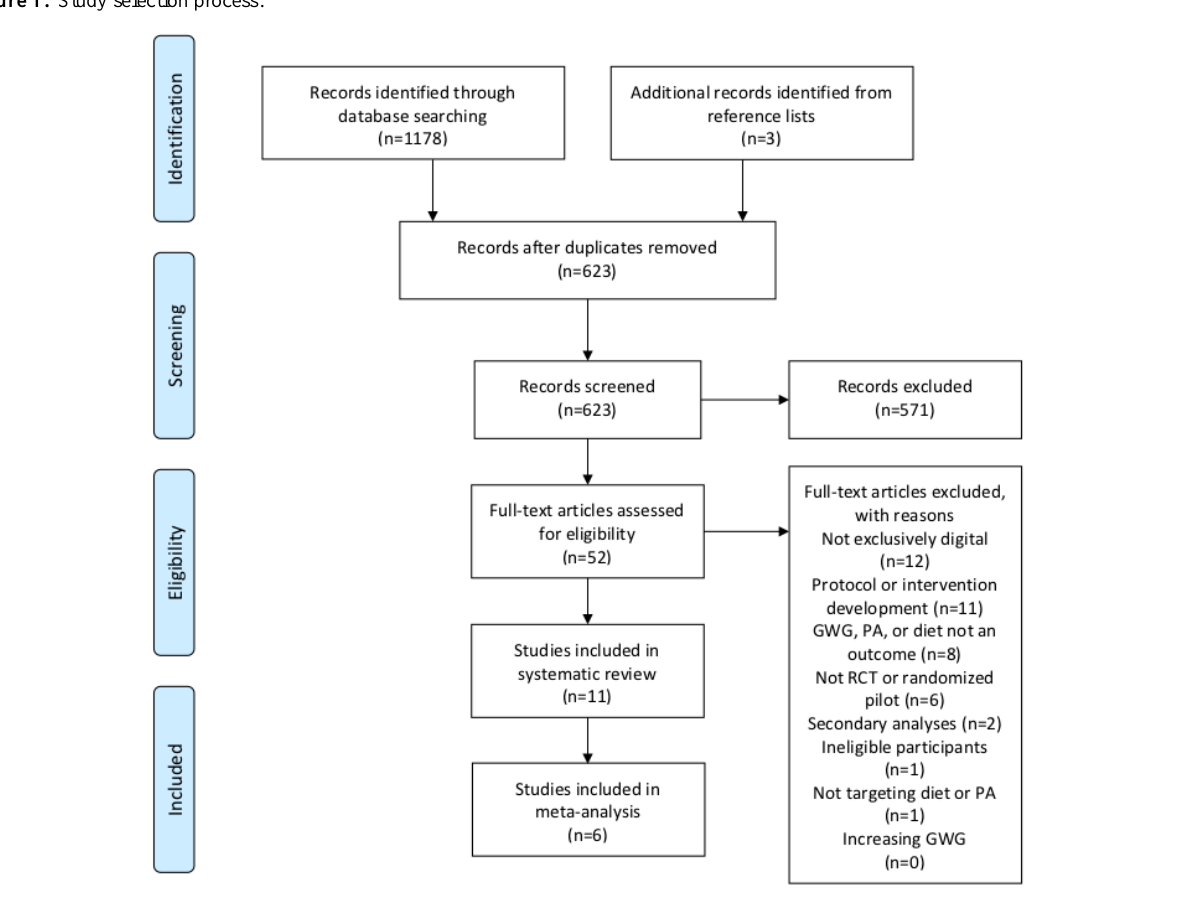
Figure 1. Study selection